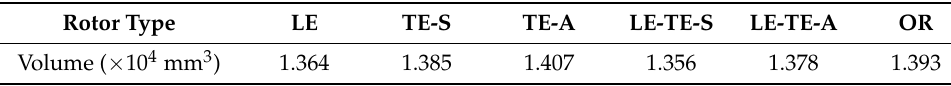
Figure 4. Planforms of different rotor models. ( a ) LE; ( b ) TE ‐ S; ( c ) TE ‐ A; ( d ) LE ‐ TE ‐ S; ( e ) LE ‐ TE ‐ A; ( f ) OR. Note: Since the rotor is a rotationally symmetric model, only half of each rotor is shown. Table 2. The overall volume of different rotor models. Table 2. The overall volume of different rotor